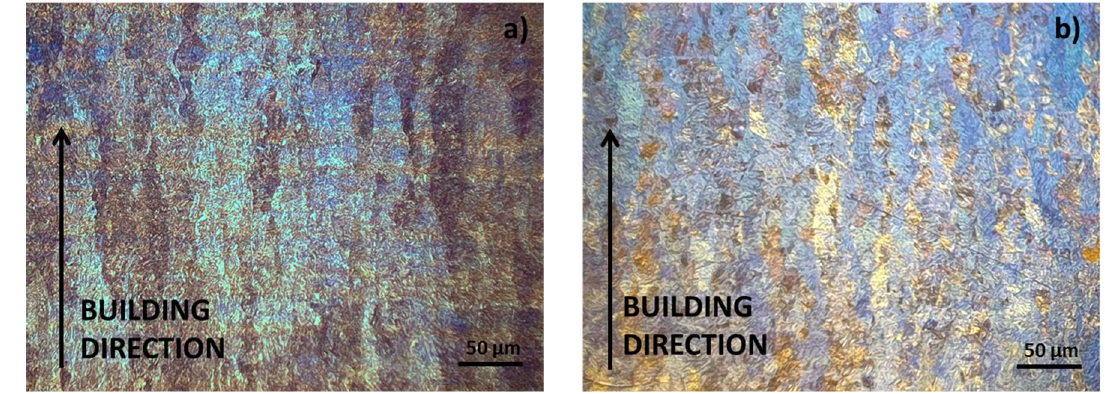
Figure 3. Optical pictures captured along the building directions for a ) EBM-MP and b ) DMLS-MP samples.